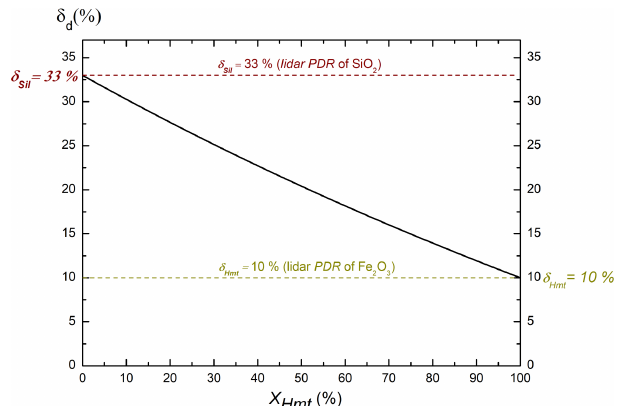
Figure 6. Numerical simulation of the 355nm lidar PDR of a two-component particle mixture (d) = { Hmt , Sil } , composed of hematite (Hmt) and silica (Sil) oxides as a function of the X Hmt = β Hmt /β d fraction of Hmt to d particle backscattering, following Eq. (8) and Appendix A, by accounting for our laboratory exper- imental findings for δ Sil = 33% and δ Hmt = 10% (see Table 2 at 355nm wavelength with coarser